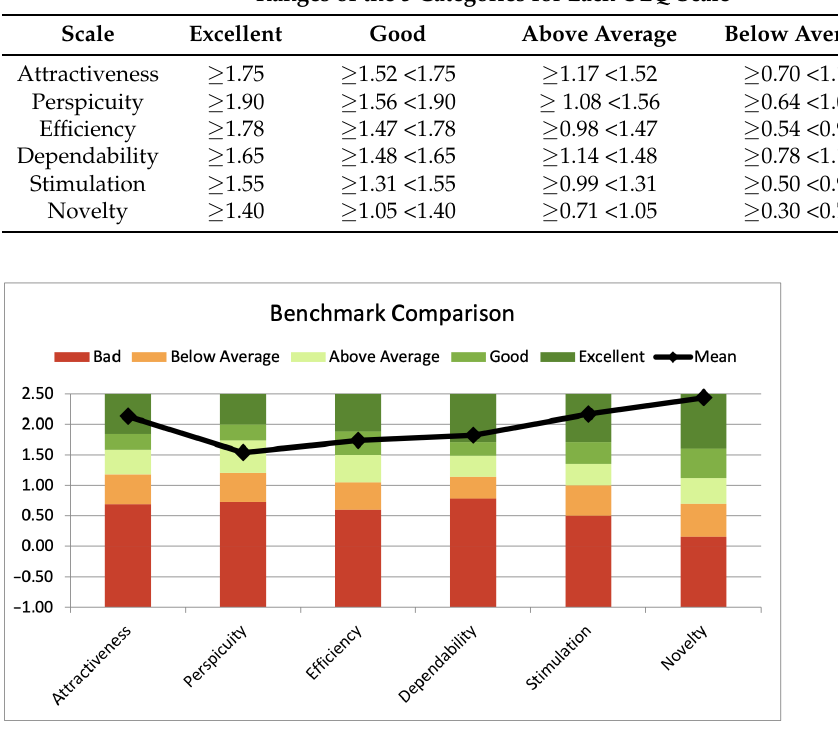
Figure 8. Comparison to the benchmark, highlighting the trend of the mean values of each scale (Attractiveness, Perspicuity, Efficiency, Dependability, Stimulation, and